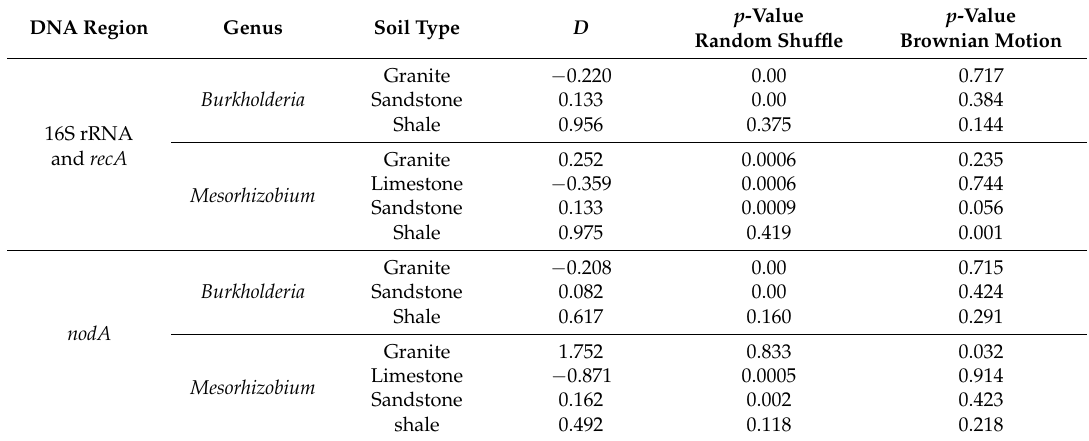
Table 1. Results of the tests of phylogenetic signals on soil types using the D statistic on the combined chromosomal gene (16S ribosomic RNA (rRNA) and recombinase A ( recA )), and the N-acyltransferase ( nodA ) trees of Burkholderia and Mesorhizobium. DNA Region